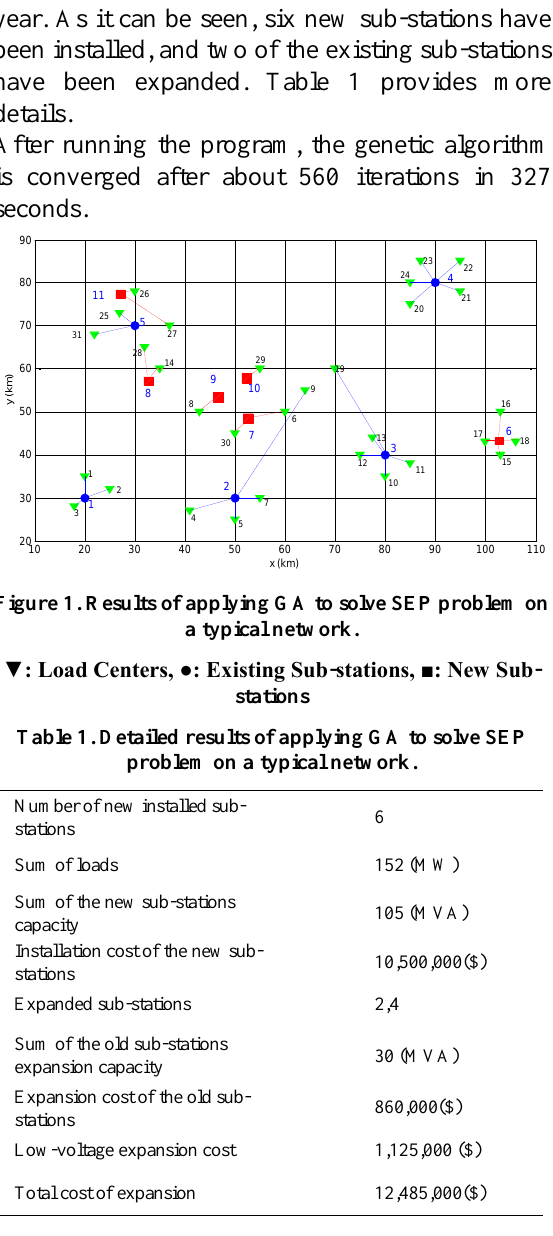
Figure 3. Results of applying BFOA to solve SEP problem on a typical